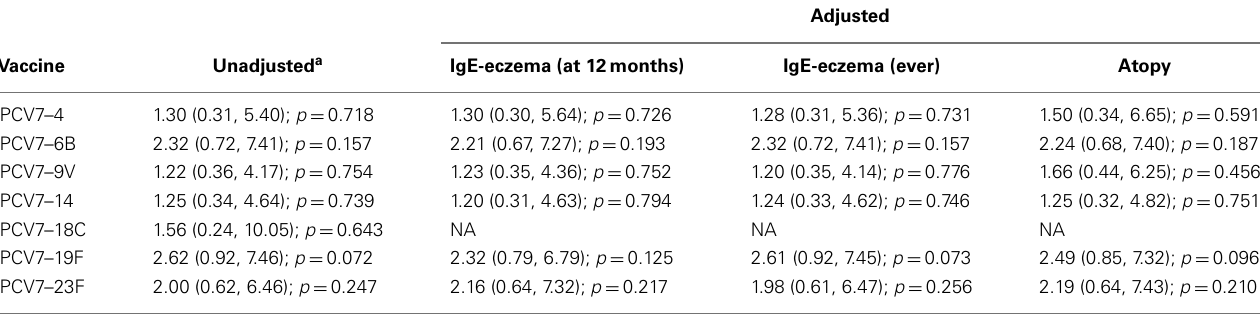
TableA3A | Summary of the PCV7 serotype-specific IgG responses ≥ 1.0 µ g/ml following adjustment for eczema and atopy .